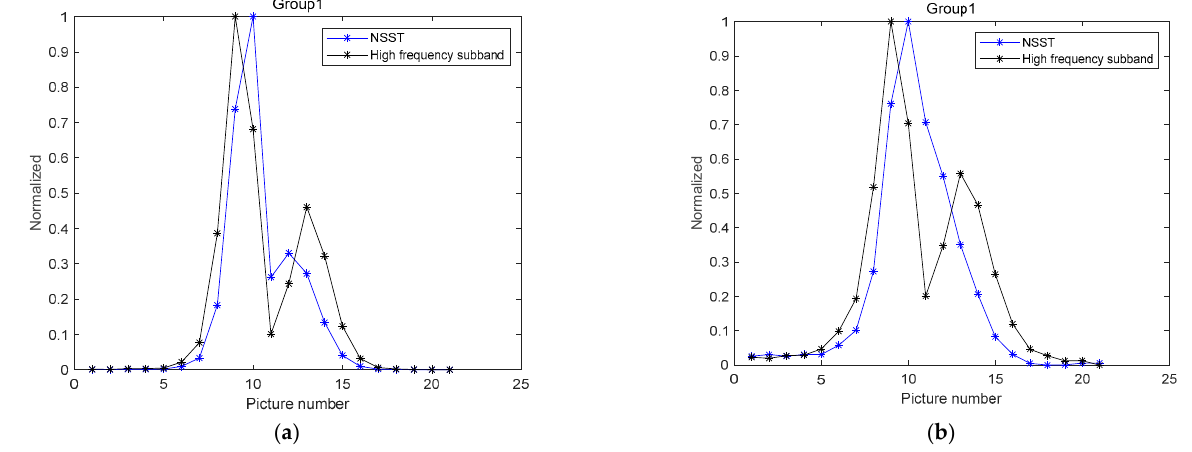
Figure 3. Comparison results of algorithm performance with and without noise: ( a ) image without noise; ( b ) image with noise.